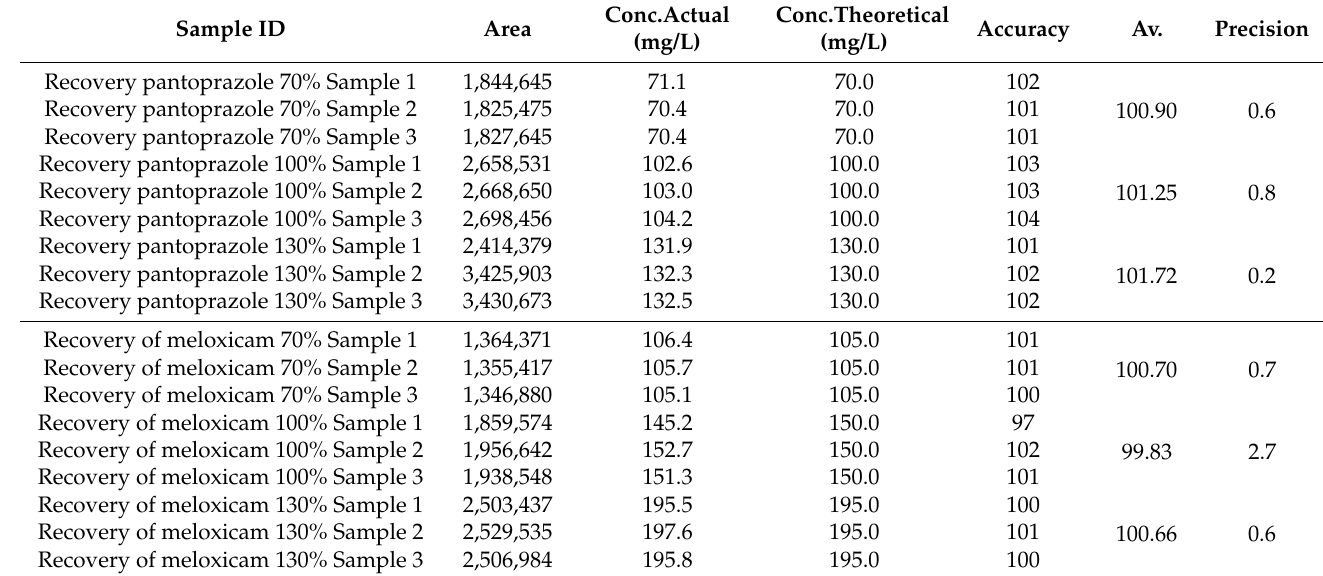
Table 8. Recovery of pantoprazole and